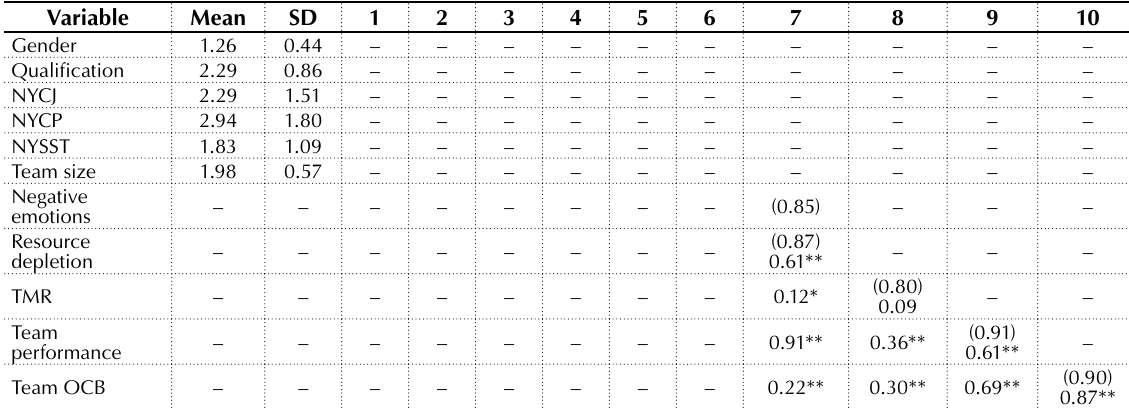
Table 2. Descriptive statistics, reliability coefficient, and correlations